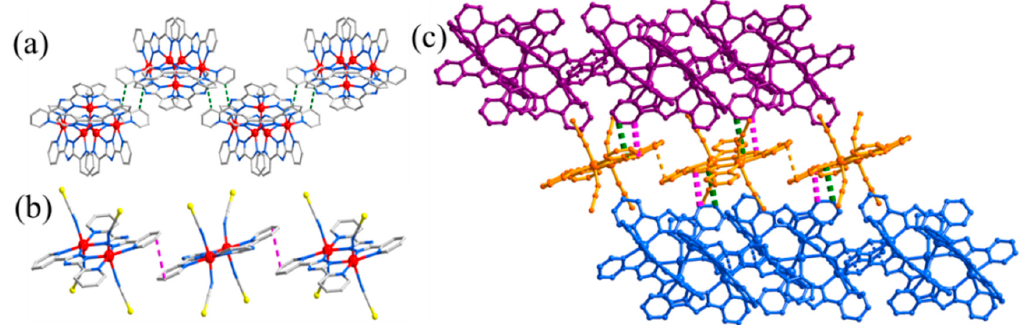
Figure 3. Structure illustrations of 2 : π - π interactions between the pentanuclear iron(II) cluster ( a ), π - π interactions between the binuclear anion ( b ), π - π interactions between the pentanuclear cation and binuclear anion ( c